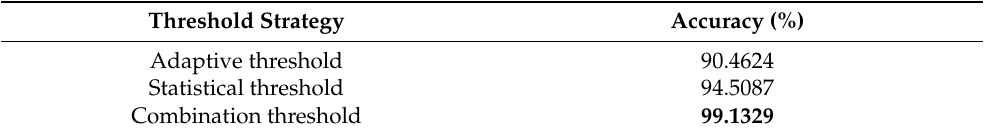
Table 7. Comparison with different thresholds on the HNUFDD dataset for fatigue driving be- havior recognition.